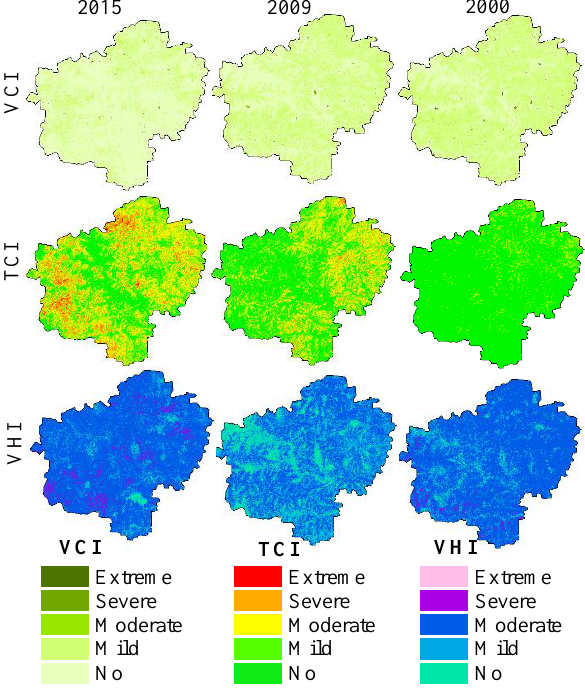
Figure 5: Spatial variation of drought due to soil moisture, thermal stresses and Vegetation health for December (Legends as per Table